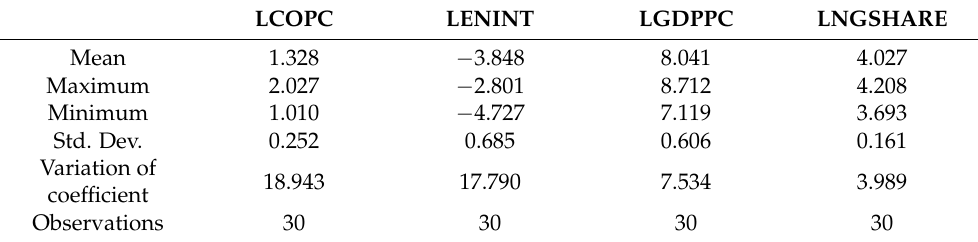
Figure 1. Historical path of the variables. Table 1. Descriptive statistics of the